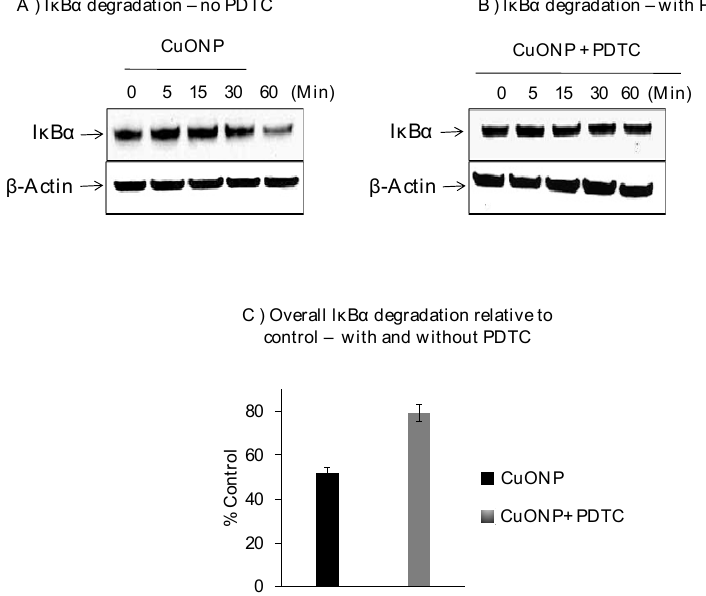
Figure 1. Effect of nanoparticles on NF κ B luciferase reporter activation. Human SH-SY5Y cells (2 × 10 4 /well) expressing a NF κ B reporter gene (transfected plasmid—pNF κ B-Lu-neo) were exposed to concentrations of nanoparticles (NPs) of CuO, Fe 2 O 3 , and ZnO at a range of 0 to 100 μ M/mL for 6 h. Luciferase reagent was added and luciferase activation signals were measured using a Veritas™ microplate luminometer. Results are expressed as fold induction. * p < 0.01, ** p < 0.001, *** p < 0.0001, for CuONPs (10 μ M, 100 μ M) compared to control, untreated, # p < 0.01 for Fe 2 O 3 NPs compared to control, ^ p < 0.01 for ZnONPs compared to control.